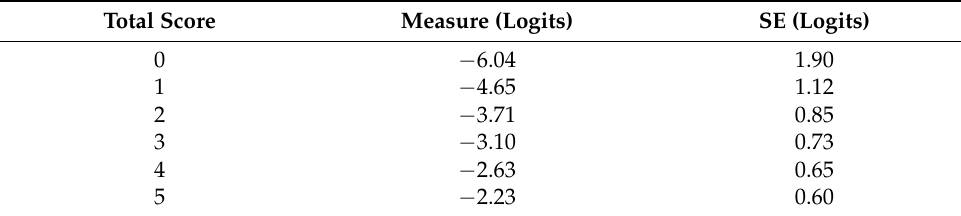
Table 5. Score-to-measure conversion of the Mini-BESTest. Total